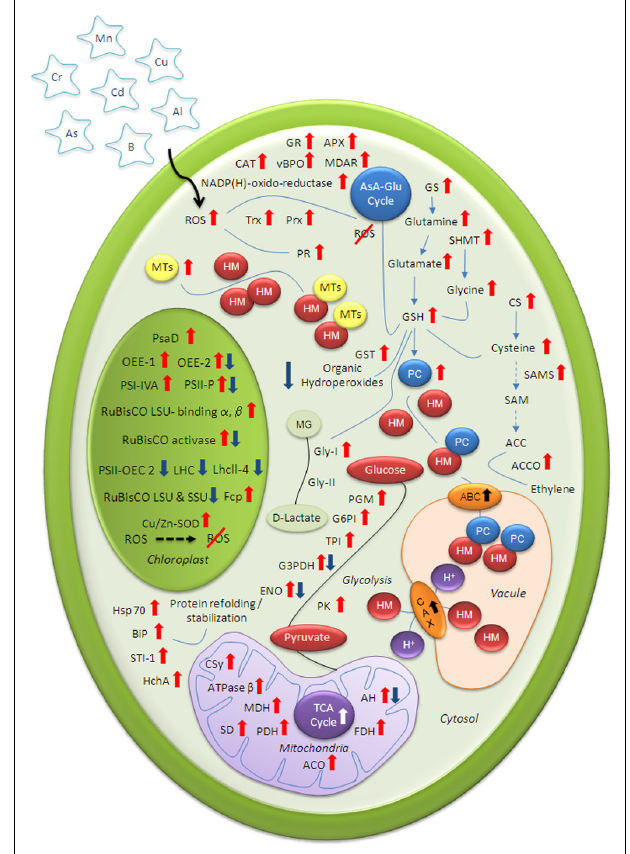
FIGURE 1 | Schematic illustration of various cellular mechanisms for mitigating heavy metal (HM) stress. Information about highlighted proteins gathered from published proteomic articles related to plant HM-toxicity. Up and down arrows indicate HM-induced increase and decrease protein abundance respectively. ATPase β , ATP synthase subunit beta; AH, aconitate hydratase; AsA-Glu, ascorbate glutathione; APX, ascorbate peroxidase; ACC, 1-aminocyclopropane-1-carboxylic acid; ACO, aconitase; CAT, catalase; CAX, cation/proton exchanger; CS, cysteine synthase; CSy, citrate synthase; ENO, enolase; FDH, formate dehydrogenase; G3PDH, glyceraldehyde-3-phosphate dehydrogenase; GR, glutathione reductase; Gly-I, glyoxalase I; GS, glutamine synthetase; GSH, reduced glutathione; LHC, light harvesting complex; LhcII-4, light-harvesting chlorophyll-a/b binding protein; LSU, large subunit; MTs, metallothioneins; MG, methylglyoxal; MDAR, monodehydroascorbate reductase; MDH, malate dehydrogenase; OEE, oxygen-evolving enhancer protein; PC, Phytochelatin; Prx, peroxidoxin; PR, pathogenesis-related; PDH, pyruvate dehydrogenase; PSII-OEC 2, photosystem II oxygen-evolving complex protein 2; PS, photosystem; ROS, reactive oxygen species; RuBisCO, ribulose-1,5-bisphosphate carboxylase oxygenase; SD, succinate dehydrogenase; SAM, S-adenosylmethionine; SSU, small subunit;Trx, thioredoxin;TPI, triosephosphate isomerase;TCA, tricarboxylic